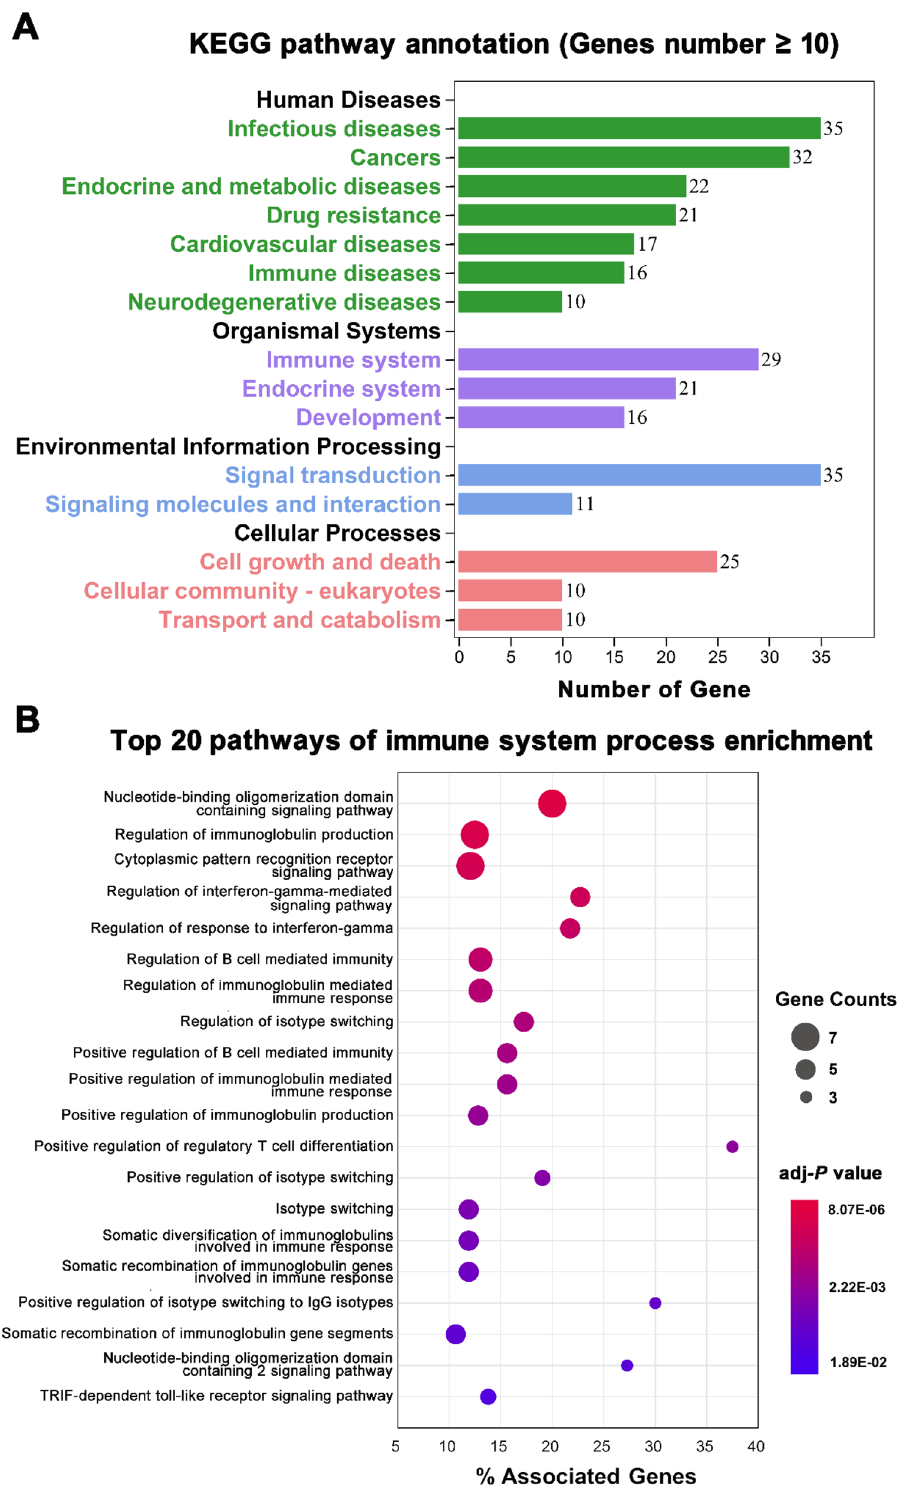
Figure 4. Enrichment analysis of the 41 cancer immune response-related genes with degree higher than or equal to 10 in the herb-compound-target (H-C-T) network. ( A ) Kyoto Encyclopedia of Genes and Genomes (KEGG) pathway annotation. Different KEGG classes are displayed in various colors. ( B ) Immune system process